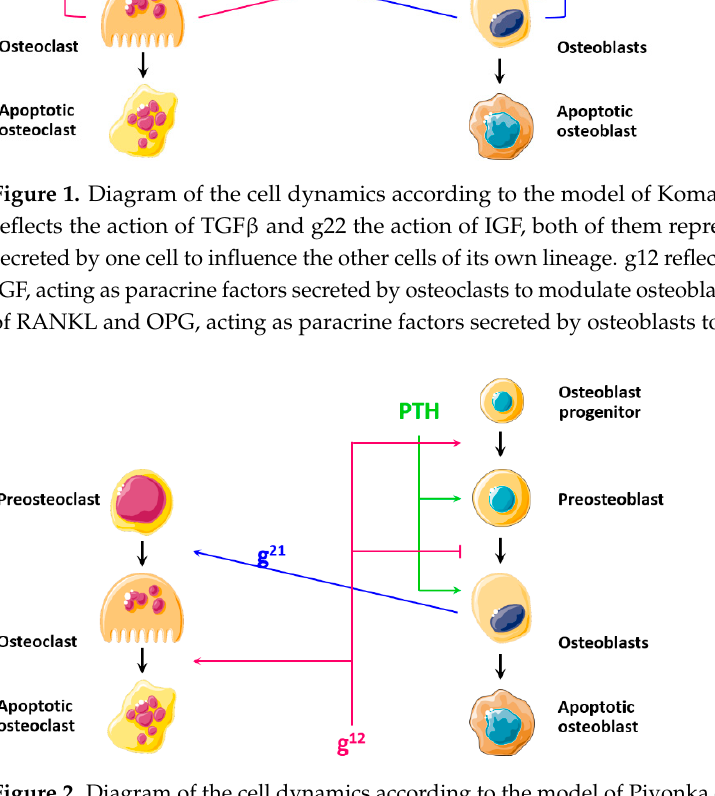
Figure 2. Diagram of the cell dynamics according to the model of Pivonka et al. [19], which considers that osteoblasts modulate osteoclast differentiation through g21. In this diagram, g12 only reflects the action of TGF β stored in the bone matrix and released by osteoclasts during the bone resorption phase, and g21 reflects the actions of RANKL and OPG expressed by osteoblasts to modulate osteoclast differentiation. The model also involves the effect of PTH, as an external factor to the BMU.